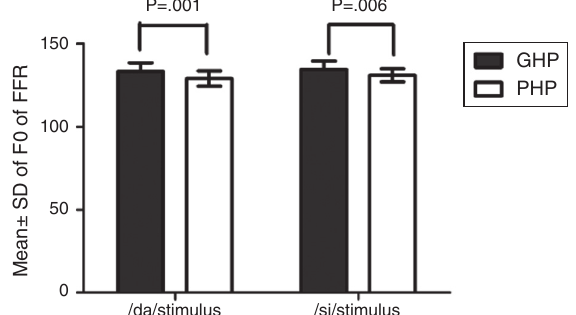
Figure 7 Mean, standard deviation and p -value of indepen- dent samples t -test on F 0 of FFR for each stimulus, in GHP and PHP groups.